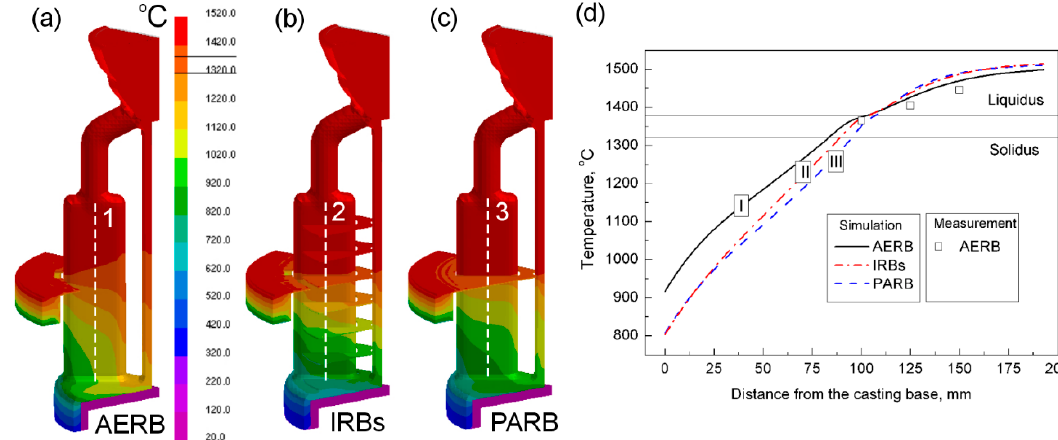
Figure 4. Predicted temperature field on mold surface ( a – c ) and temperature profiles along the symmetry axis of casting ( d ) for the process with the application of ( a ) adjusted external radiation baffle (AERB); ( b ) inner radiation baffles (IRBs); ( c ) perfectly adjusted radiation baffle (PARB). Results are presented for time 1081 s from the start of the filled mold withdrawal.